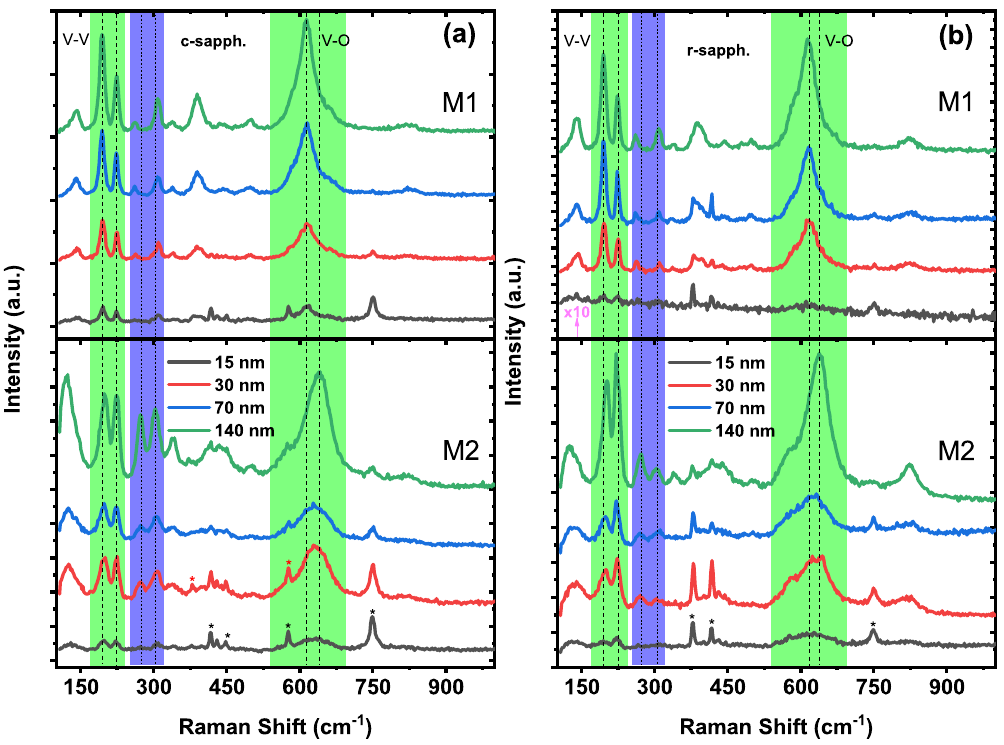
Figure 5. Room temperature Raman spectra of VO 2 and Cr-doped VO 2 films with different thicknesses on c-plane ( a ) and r-plane ( b ) sapphire substrates. The shaded green areas highlight the V–V and the V–O Raman modes while the shaded blue areas indicate the shift of the M1 Raman modes in the M2 phase in addition to the shift of the V–O Raman modes. The asterisk indicates the respective substrate’s Raman